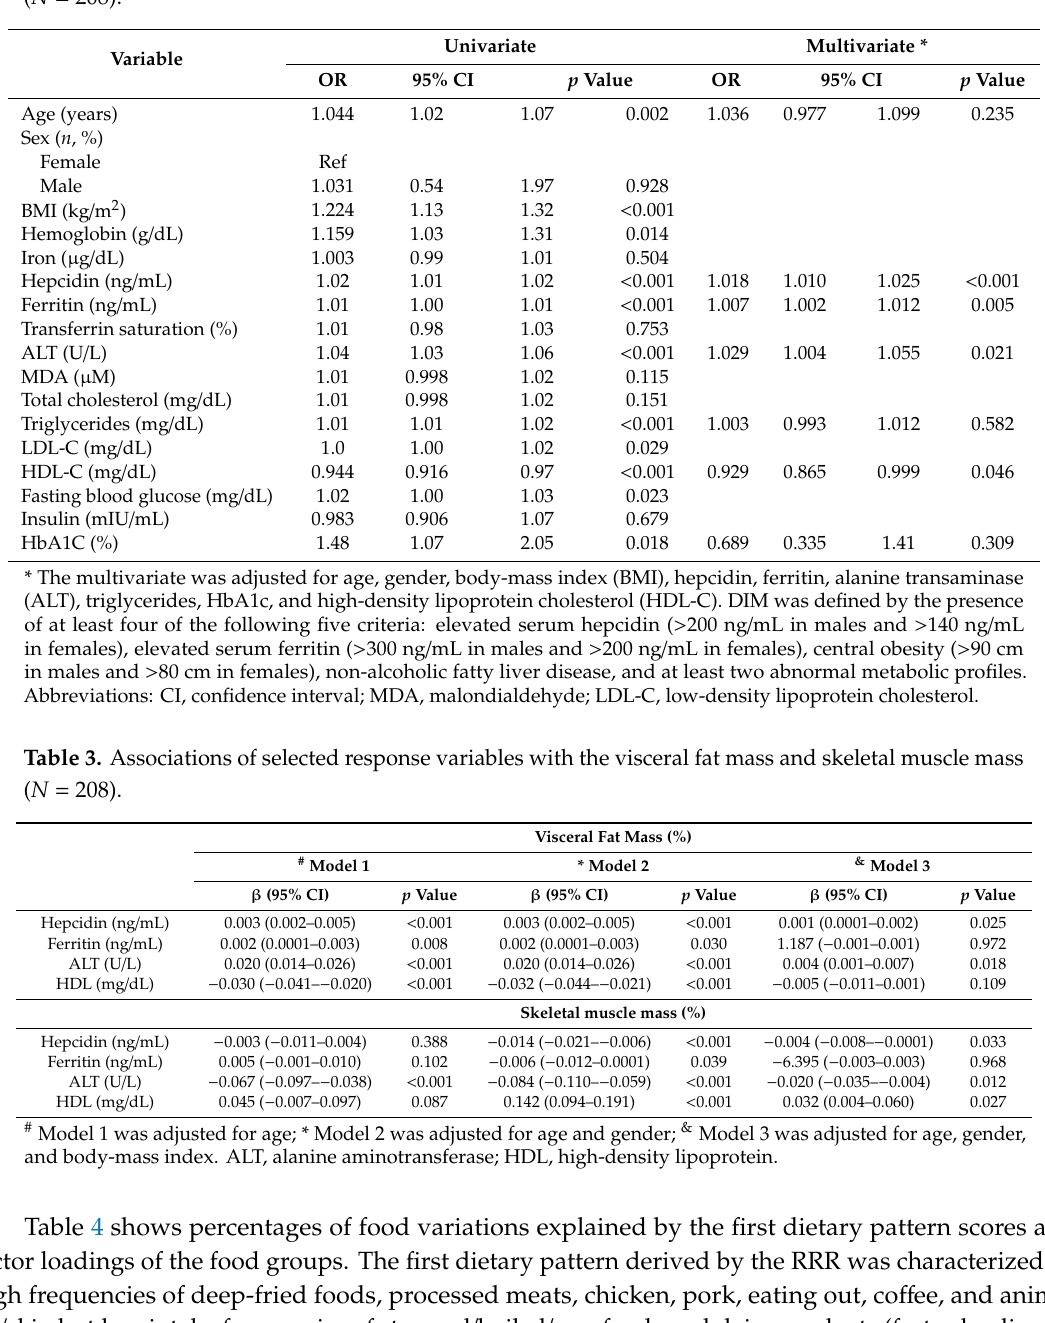
Table 2. Multivariate logistic regression of risk factors associated with dysregulated iron metabolism ( N = 208).